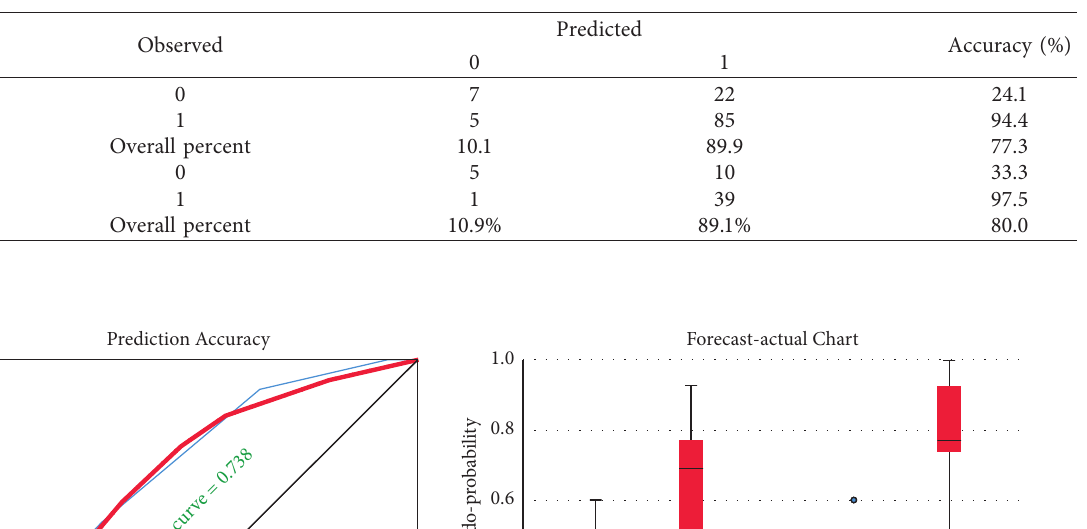
Table 12: Model classification prediction results.